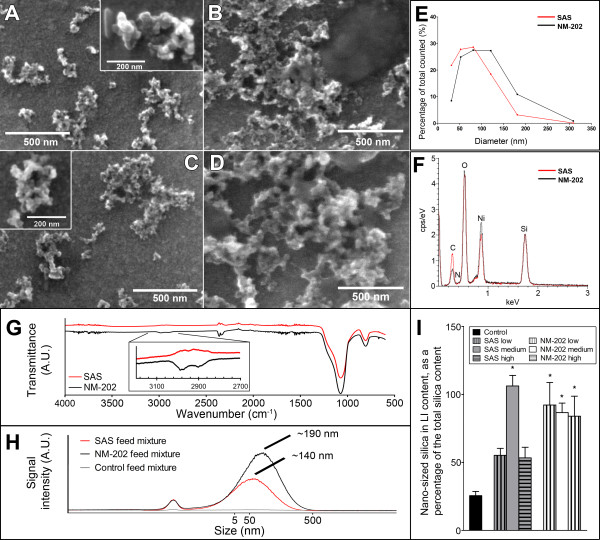
Physicochemical characterization of synthetic amorphous silica (SAS) and the OECD representative nano-sized silica (NM-202). SEM micrographs of SAS in (A) water + 0.05% BSA and (B) feed, and of NM-202 in (C) water + 0.05% BSA and (D) feed. (E) SEM size distribution pattern of SAS and NM-202 in water + 0.05% BSA, showing larger sizes for NM-202. The size limit of detection lies at 25 nm. (F) EDX characterization of SAS and NM-202 agglomerates in water containing 0.05% BSA, demonstrating the presence of Si, O, and C on the surface of both materials. The peak representing nickel can be attributed to the nickel coated membrane that was used for sample preparation. (G) FTIR spectra of SAS and NM-202 showing mild C-H stretching vibrations for NM-202 (inset). (H) HDC-ICP-MS chromatogram showing the size distribution and concentration (area under the curve) of nano-sized silica in SAS, NM-202, and in control feed mixtures. (I) The fraction of silica in the nano-size range (i.e. with a size of 5–200 nm; measured by HDC-ICP-MS) given as a percentage of the total silica content (measured by ICP-MS) in the large intestinal (LI) contents, 24 hours after the last exposure (mean ± standard error of the mean; n = 5). * Significant difference versus the control (p < 0.05).